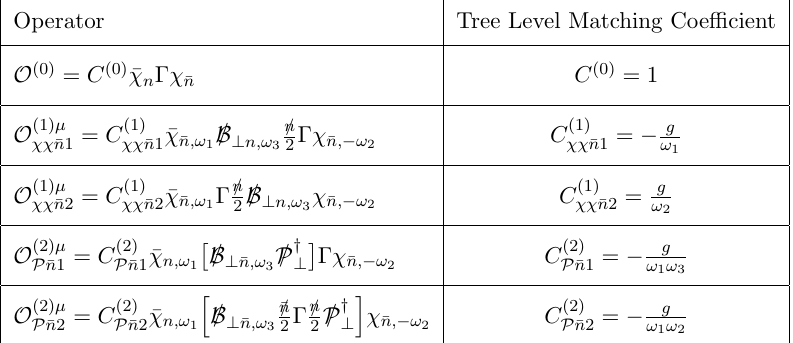
Table 3 . Hard scattering operators that contribute to the thrust cross section to with their tree level matching coe(cid:14)cients. These operators and matching coe(cid:14)cients were derived in [31]. Note that, for the case of e + e (cid:0) annihilation the Wilson coe(cid:14)cients of the hard scattering operators involving ultrasoft emissions, vanish at tree level, and therefore do not contribute at LL [31]. For a comparison between the subleading hard scattering operators for the case of e + e (cid:0) annihilation and gluon induced Higgs decay, see section 3.4.3 of [32]. T -Product Example Diagram